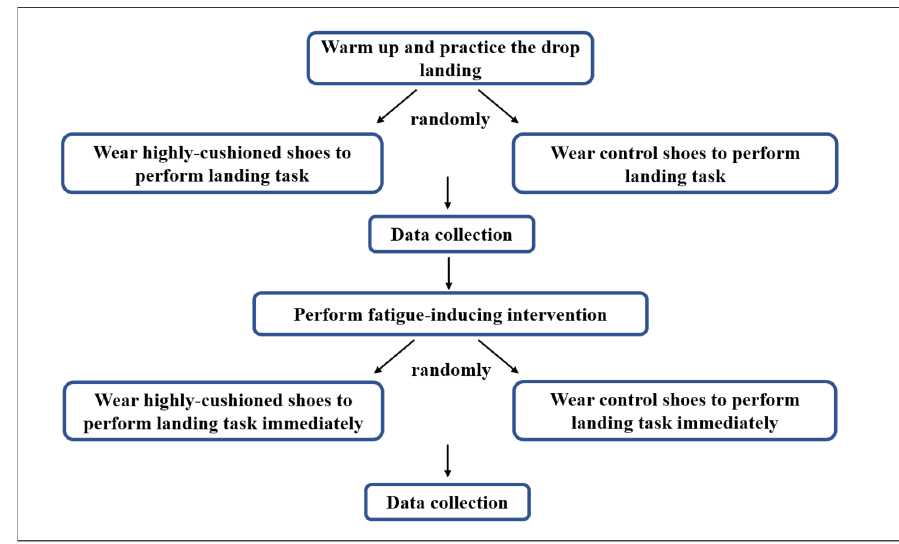
Figure 3. Diagram of the experimental flow chart.